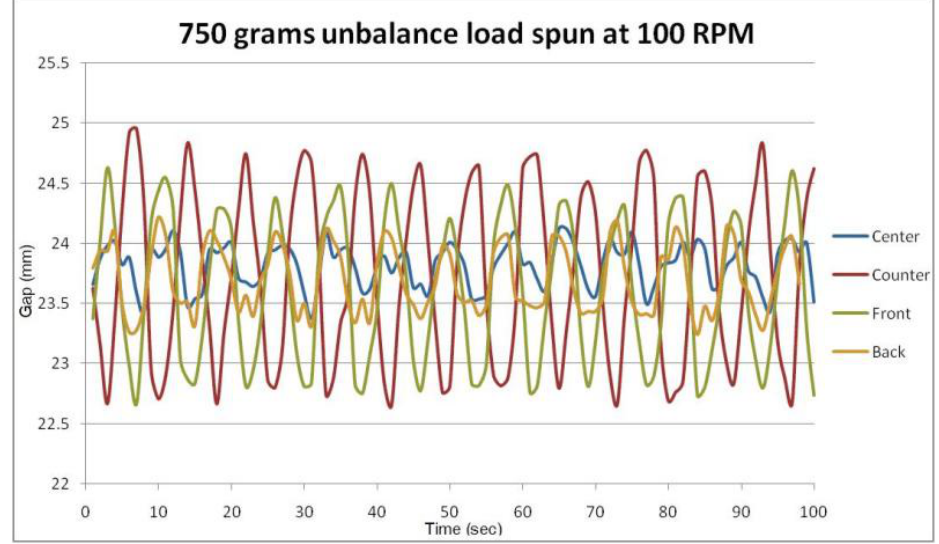
Figure 7. Displacement vs. Time plot for test carried out at 100 rpm with 750 g unbalanced load.